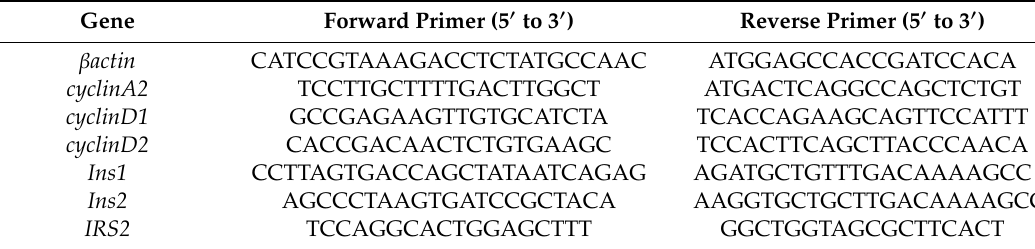
Table 1. Primers used for quantitative real-time polymerase chain reaction (PCR). Gene Forward Primer (5 (cid:48) to 3 (cid:48) ) Reverse Primer (5 (cid:48) to 3 (cid:48)